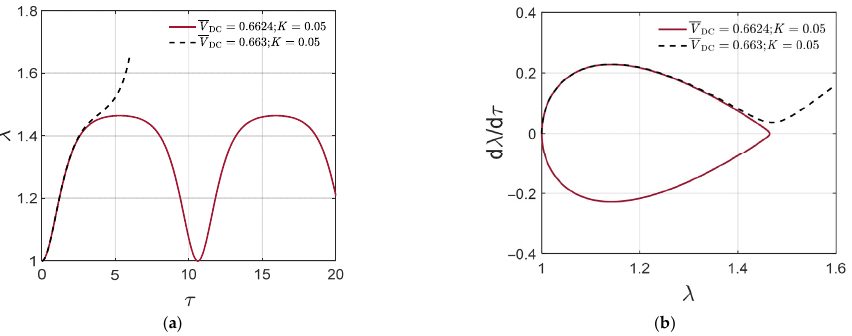
Figure 4. The DC dynamic response of the electro-magneto-active polymer to H = H S = 0 and K = 0.05. ( a ) Time history and ( b ) phase plane